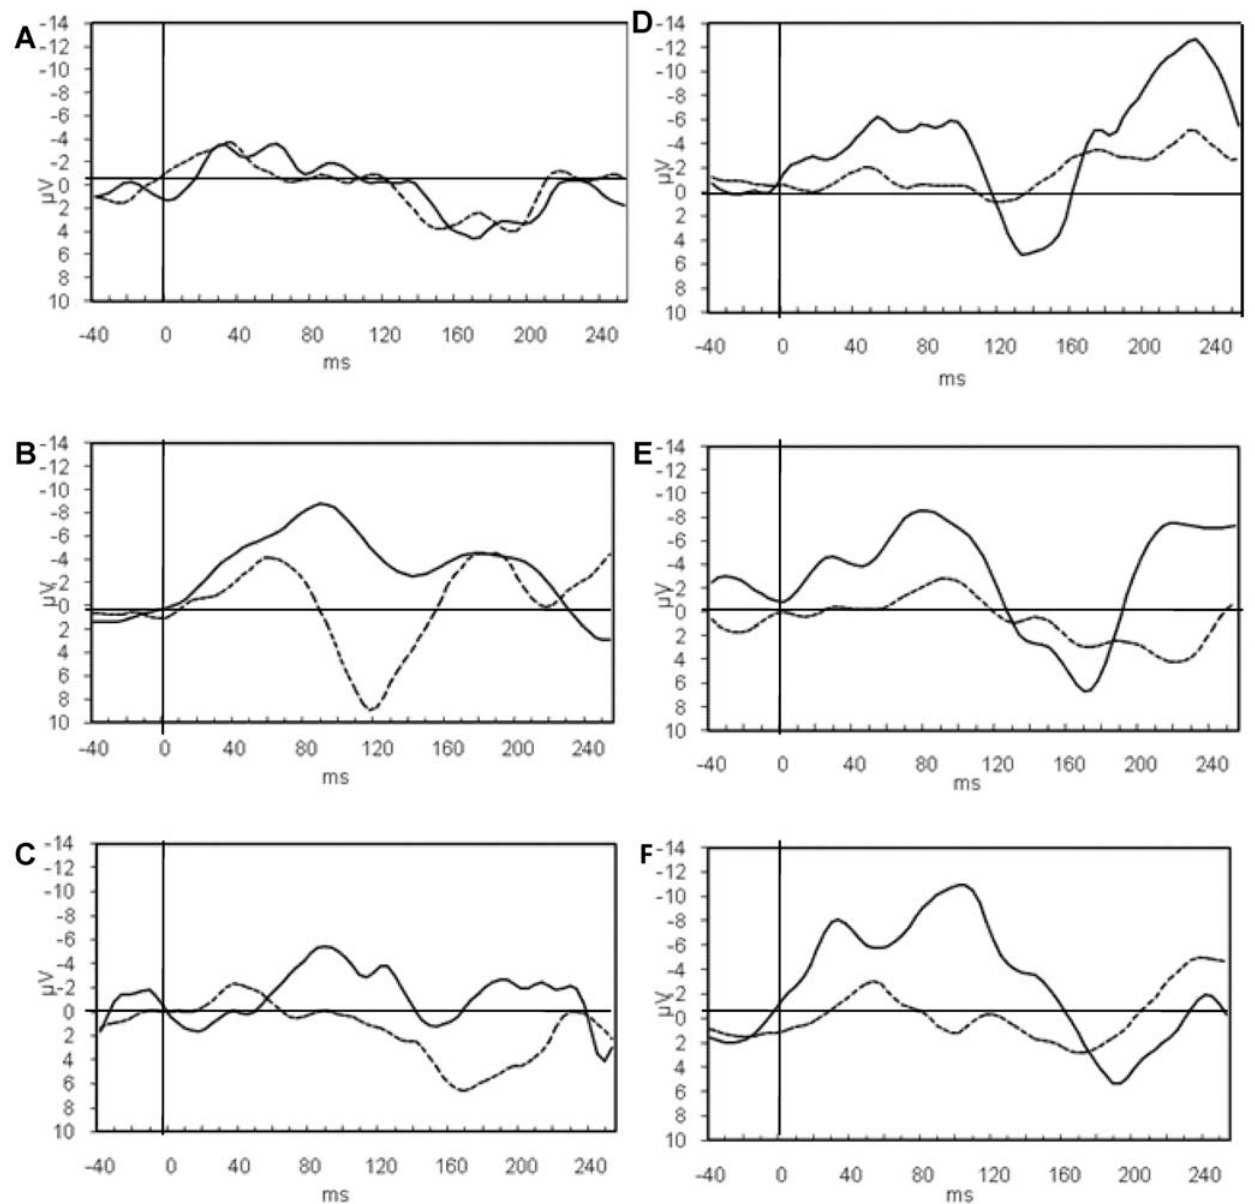
Figure 2. ERN and CRN amplitudes in tests 1, 2 and 3 in dyslexics and controls. A grand average for the ERN-CRN (response-locked) components for correct response (CRN) and for error response (ERN), represented by the dashed and the solid lines, respectively, for tests 1 (A,D), 2 (B,E) and 3 (C,F) in dyslexics (left column, A,B,C) and controls (right column, D,E,F) at the Cz electrode. The ERN is seen between 30 and 150 ms after response denoted by the vertical line at time 0. Note that the negative Y axis is plotted